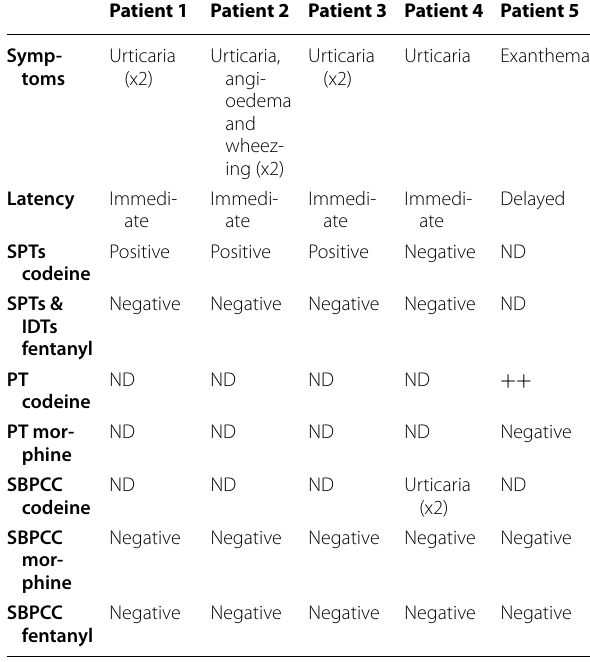
Table 1 Characteristic of patient and test